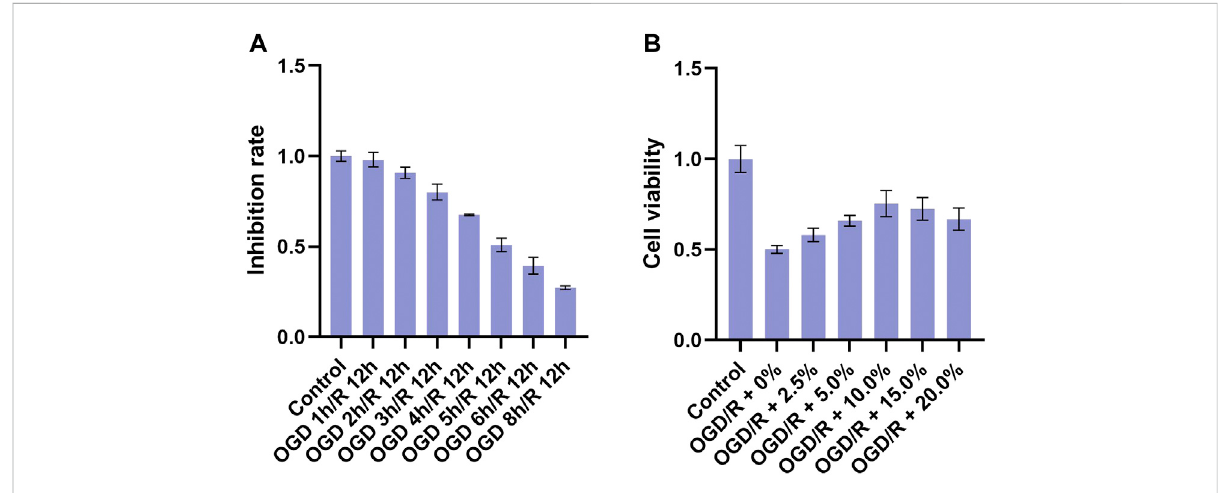
FIGURE 2 Inhibition rate and different concentrations of THSWD-containing serum. Notes: (A) inhibition rate (B) cell viability.